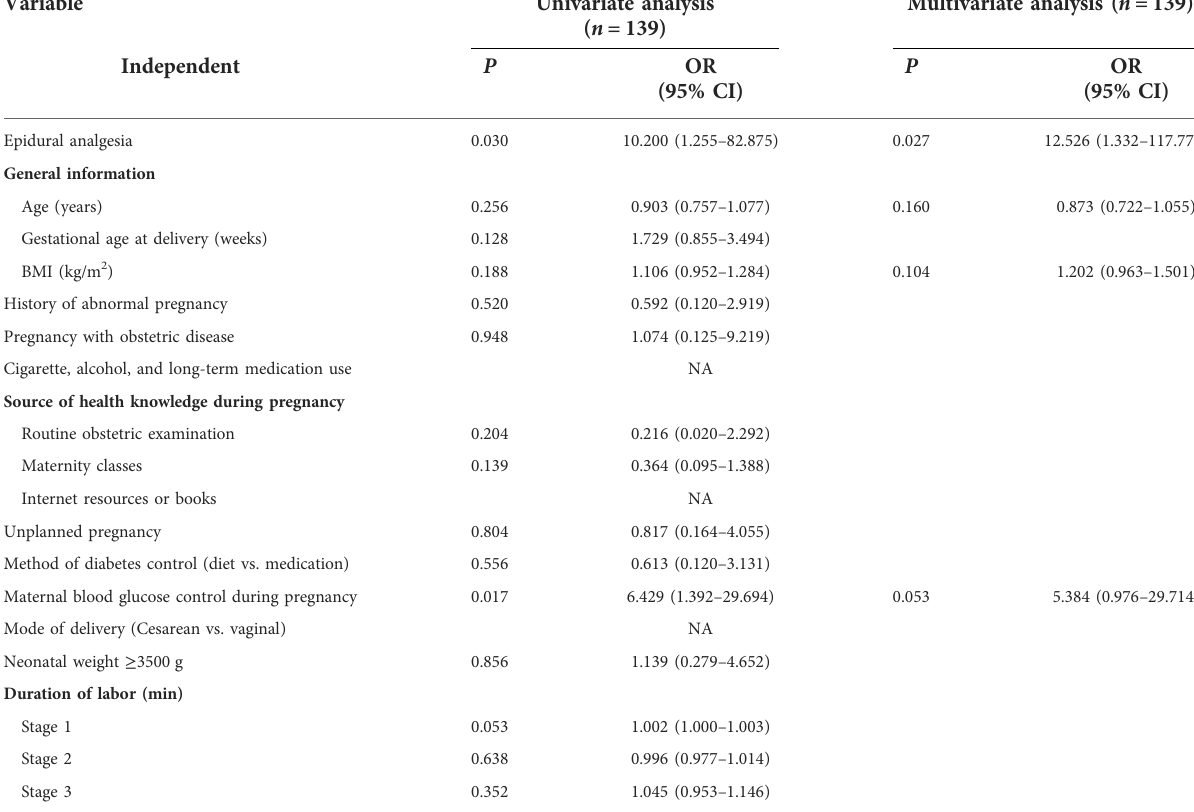
TABLE 5 Results of univariate and multivariate analyses of factors in fl uencing the rate of neonate transfer to the NICU for hypoglycemia treatment after PSM.